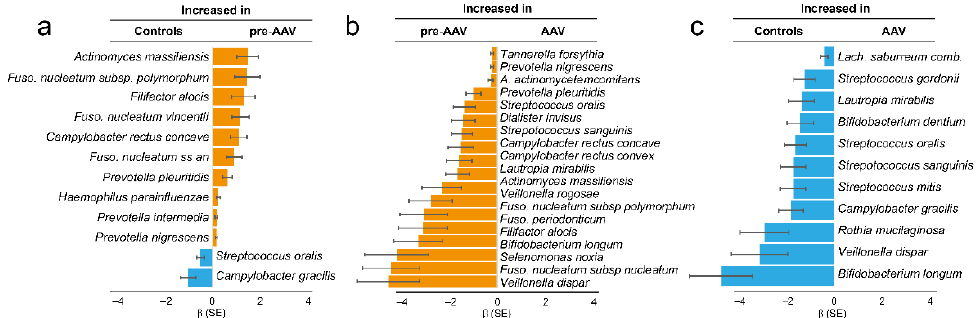
Figure 1. Levels of IgGs against oral bacteria in samples from controls and patients with pre-symp- tomatic AAV (pre-AAV) and established AAV (AAV). Species with significant differences ( p ≤ 0.001) are displayed. Checkerboard immunoblotting was used to detect IgG levels against 53 oral bacterial species/subspecies. Signals were evaluated by logistic regression adjusted for sex, age, and sample type. The bars show beta values ( β ) and standard error (SE) for the subgroups. Blue indicates in- creased levels in controls, and orange indicates increased levels in pre-AAV